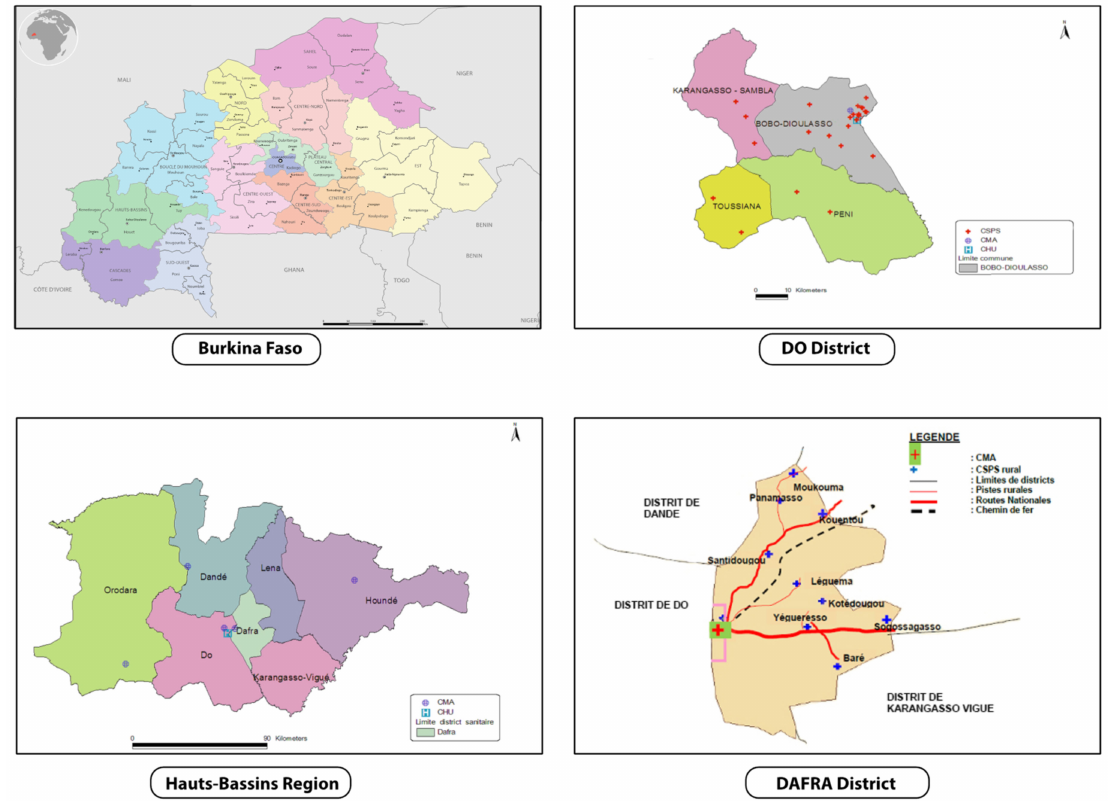
Figure 2. Study area (rural zones of D ô and Dafra districts in Hauts-Bassins Region). Adapted from Plan d’action sanitaire de D ô et Dafra